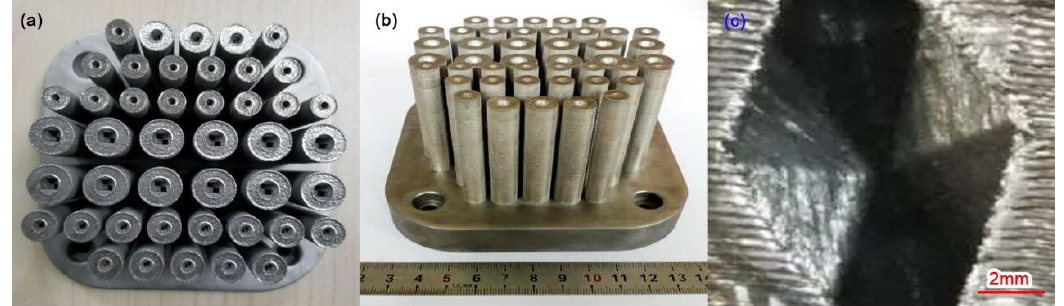
Figure 5. Selective laser melting of the micro reacting pipe and complex inner structure: ( a , b ) as-built micro reacting pipes; ( c ) the inner structure in the reacting pipe.